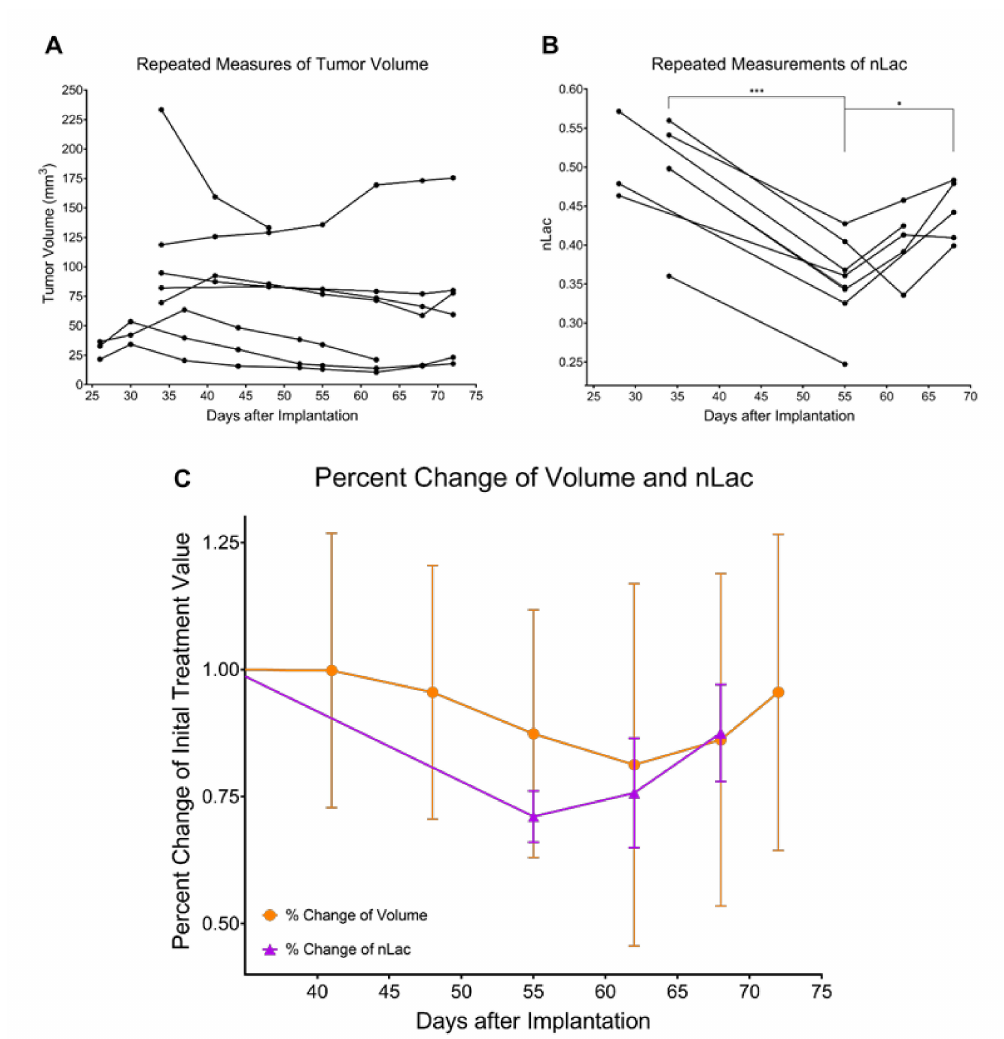
Figure 7. Percent change of nLac, but not tumor volume, is significantly altered during tumor regression and recurrence. Repeated measures of tumor volume are acquired over time in treated mice with anatomic MRI ( A ) and hyperpolarized MRS ( B ). At each time-point, volume and nLac were normalized to their initial value following treatment and plotted as percent change over time ( C ). The data were tested for significance using mixed-effects analysis with the Geisser–Greenhouse correction, and comparisons that produced p < 0.05 were deemed significant. * p < 0.05, *** p <